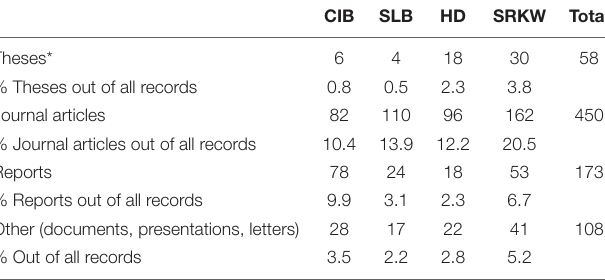
TABLE 4 | Most common types of records (1975-May 2021) obtained for four target odontocete populations [Cook Inlet beluga (CIB), St. Lawrence beluga (SLB), Hector’s dolphins (HD), and southern resident killer whale